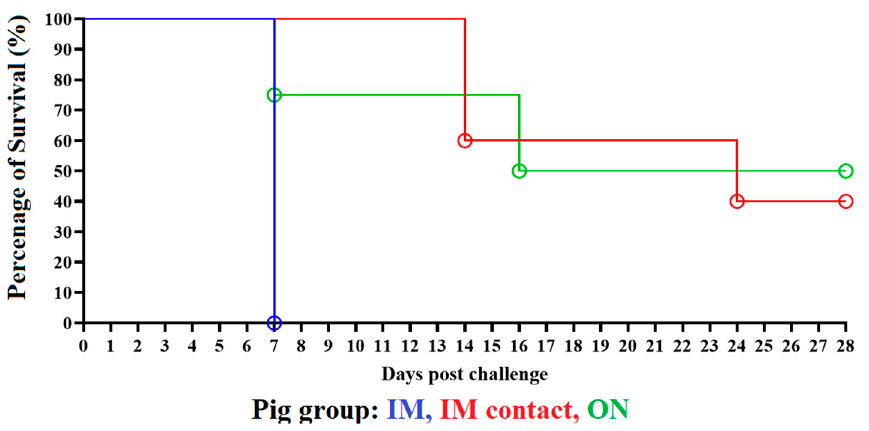
Figure 2. Kaplan-Meier survival curve of animals inoculated with ASFV-DR21 IM (blue), ON (green), or by contact (red) from day 1–28 pi. Data are presented as percentage of survival of animals within a study group.